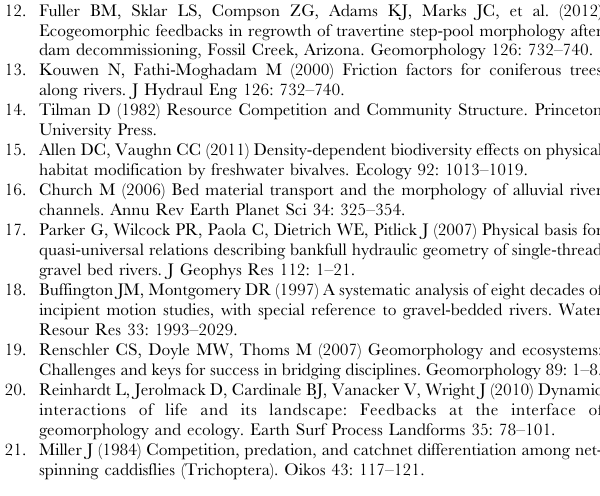
Table S1 Net density has the potential to play a significant role in influencing the threshold of sediment motion [22]. We did find that there were differences in the number of caddisfly settlers, which may translate to differences in net density, between the monoculture treatments of Arctopsyche and Ceratopsyche (Figure S2). In spite of this, we found little evidence that differences in final density across species treatments influenced critical shear stress in the experiment. We compared two mixed effects models, where the full model included critical shear stress in the monocultures as a function of the fixed effects of caddisfly species treatment, caddisfly density, and their interaction and the random effect of block. After finding that the interaction term and the density term were non-significant, we ran a reduced model that included the fixed effect of treatment and the random effect of block. Model selection criteria indicate that the full model does not explain any more variation in the data than the reduced model, suggesting that differences in caddisfly density across treatments had minimal impact on the threshold of sediment motion in our experiment. Table S2 Comparison of the estimated hydraulic variables of the flumes under conditions for incipient motion of the control (no caddisflies) and polyculture treatments to nearby Convict Creek, CA.